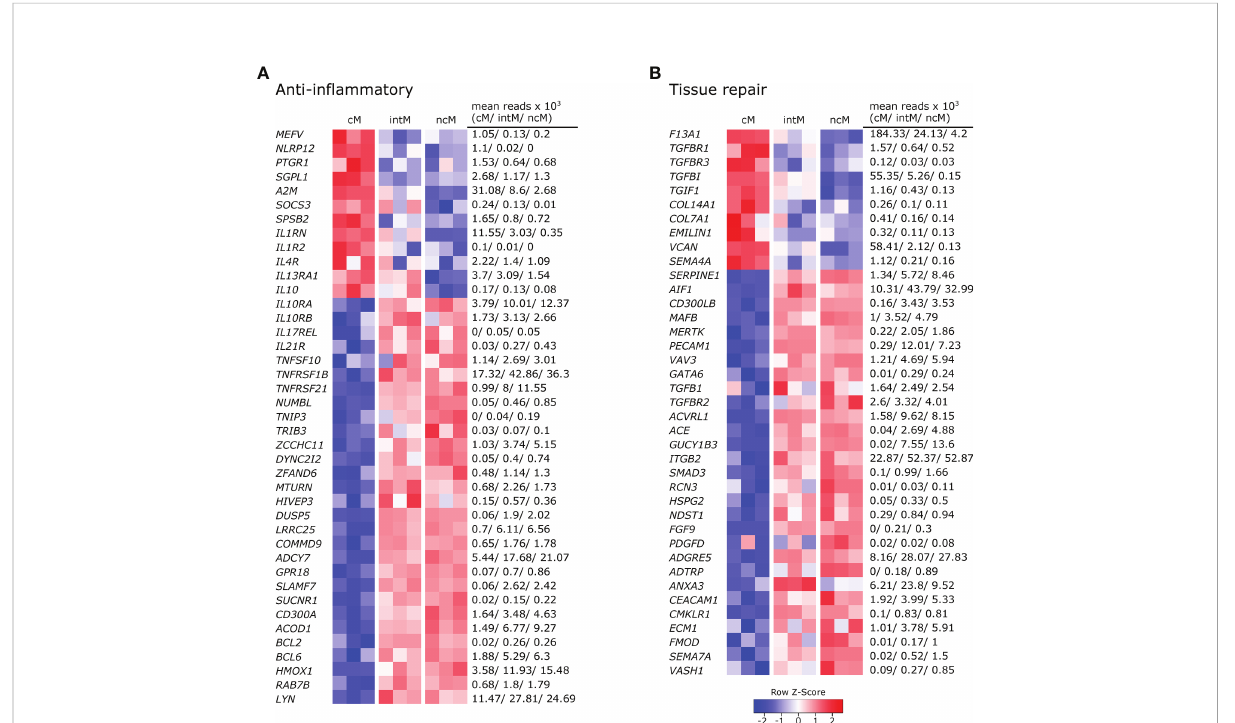
FIGURE 4 Gene expression associated with anti-in fl ammatory responses and tissue repair. Illumina sequencing was performed on RNA isolated from sorted monocyte subsets (cM, intM, ncM) of three animals. Heatmaps show row z-scores calculated from log2-transformed normalized counts of selected genes associated with anti-in fl ammatory responses (A) , and tissue repair (B) . Mean kilo reads for each subset and gene are given to the right of each heatmap. Genes were selected based on pairwise comparisons with DESeq2 (adjusted p-value < 0.05) and literature